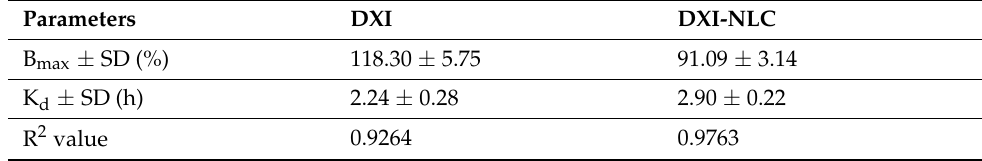
Table 5. Results of hyperbola equation for cumulative DXI release vs. time.